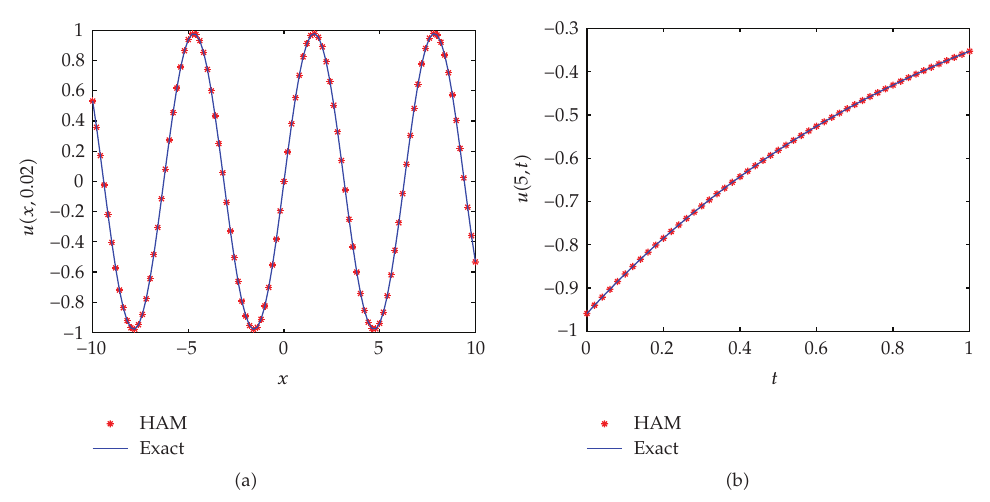
Figure 1: The comparison of the 6th-order HAM and exact solution with h (cid:8) − 1 , α (cid:8) β (cid:8) 1.